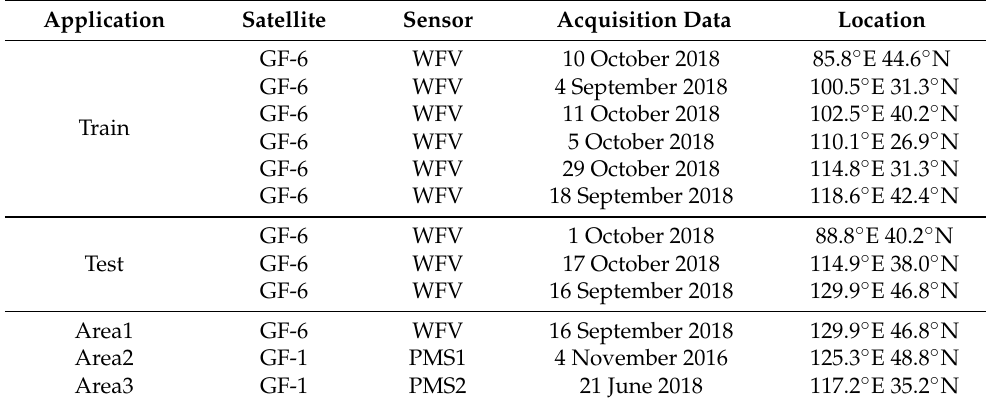
Table A1. Data acquisition for the study